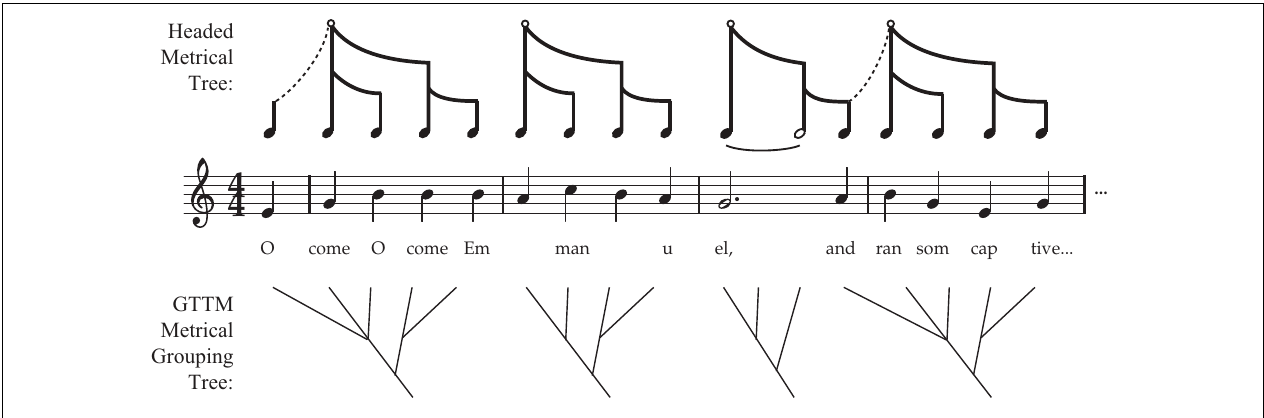
FIGURE 3 | Comparison of Headed Metrical Trees with GTTM Metrical Grouping Trees. This figure illustrates two different approaches to anacrusis, comparing the current proposed approach with the (non-headed) GTTM approach of Lerdahl and Jackendoff (1983). In my proposal, the pickup notes